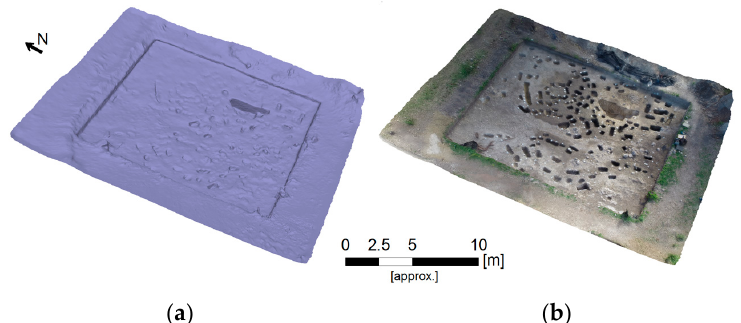
Figure 3. Photogrammetric detail, as ( a ) mesh; and ( b ) textured model, of excavation area U34 (see location in Figure 4c) at El Flaco, displaying the transected postholes that form circular shapes.